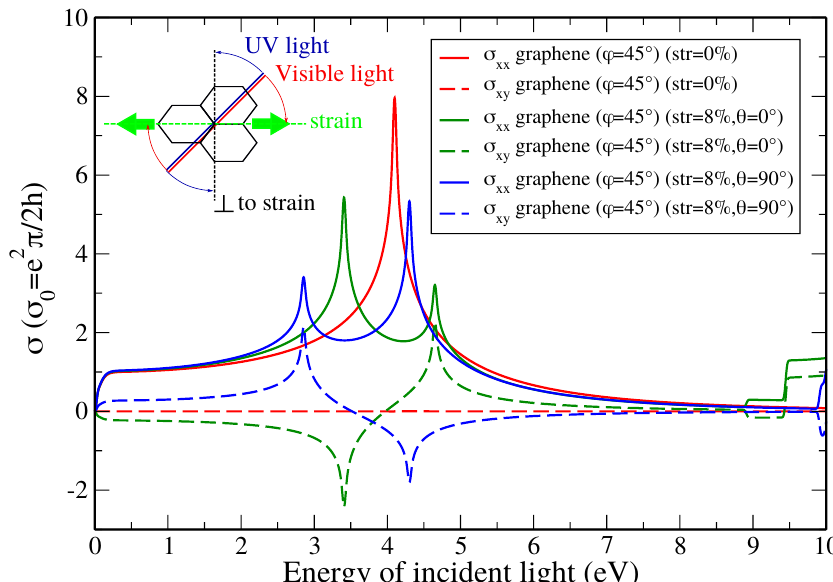
Figure 6. Optical Hall conductivity σ xy of unstrained and 8% strained graphene along armchair ( θ = 0 ◦ ) and zigzag ( θ = 90 ◦ ) direction for incoming light polarized obliquely ( φ = 45 ◦ ). Inset: Sketch illustrating the Faraday rotation mechanism of linearly polarized light (red and blue lines) in uniaxially strained graphene (green line). Visible (UV) light rotates (anti-)clockwise when strain is applied along the armchair